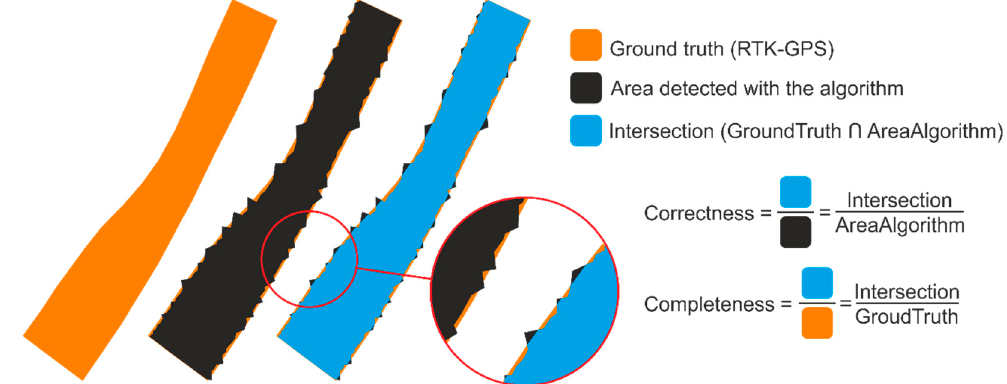
Figure 8. Graphic representation of the ground truth, detected area, and how the correctness and completeness are calculated.